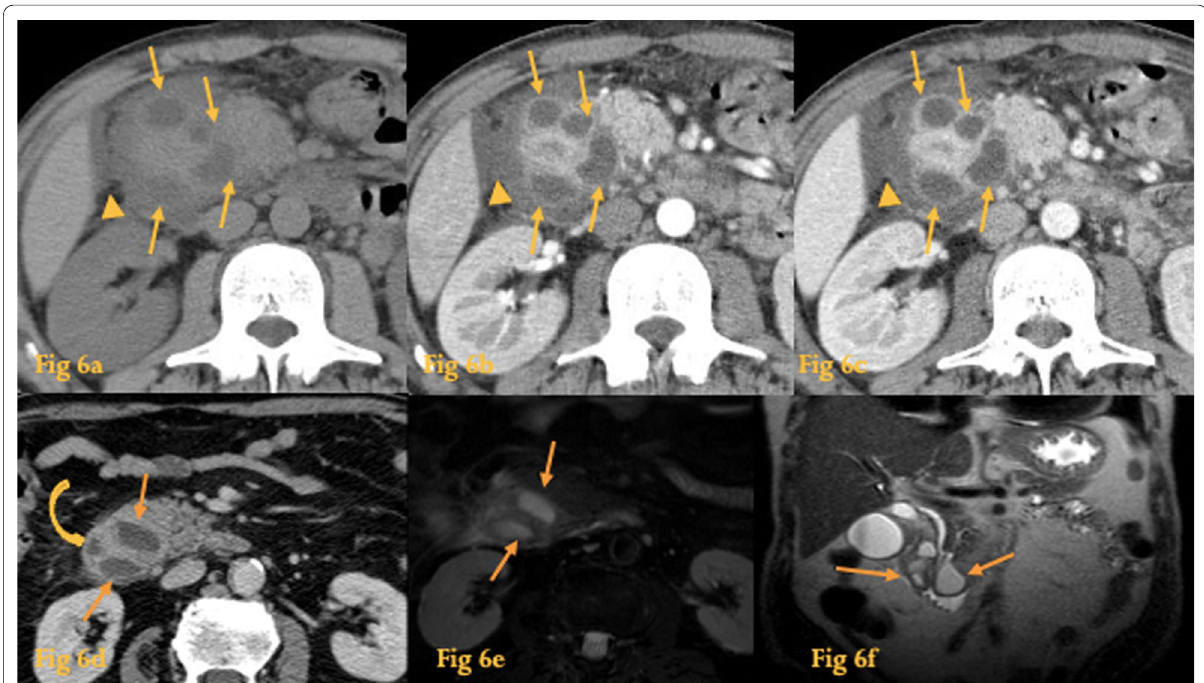
Fig. 6 Cystic dystrophy of the duodenal wall. Abdominal CT of a patient with abdominal pain ( a – c )—there is parietal thickening and several cystic lesions surrounding the duodenum (arrows), best evaluated after contrast administration ( b , c ). These cysts have a preferential localization in the mesenteric side. Densification of the periduodenal fat and a small amount of fluid surrounding the duodenum (arrowheads) is also seen. Abdominal CT of another patient ( d )—duodenal intramural cyst‑like lesions with fluid density (arrows). The cysts narrow and shift the duodenal lumen to the right. In abdominal MR ( f , e ), cystic lesions (arrows) present high signal intensity on T2w